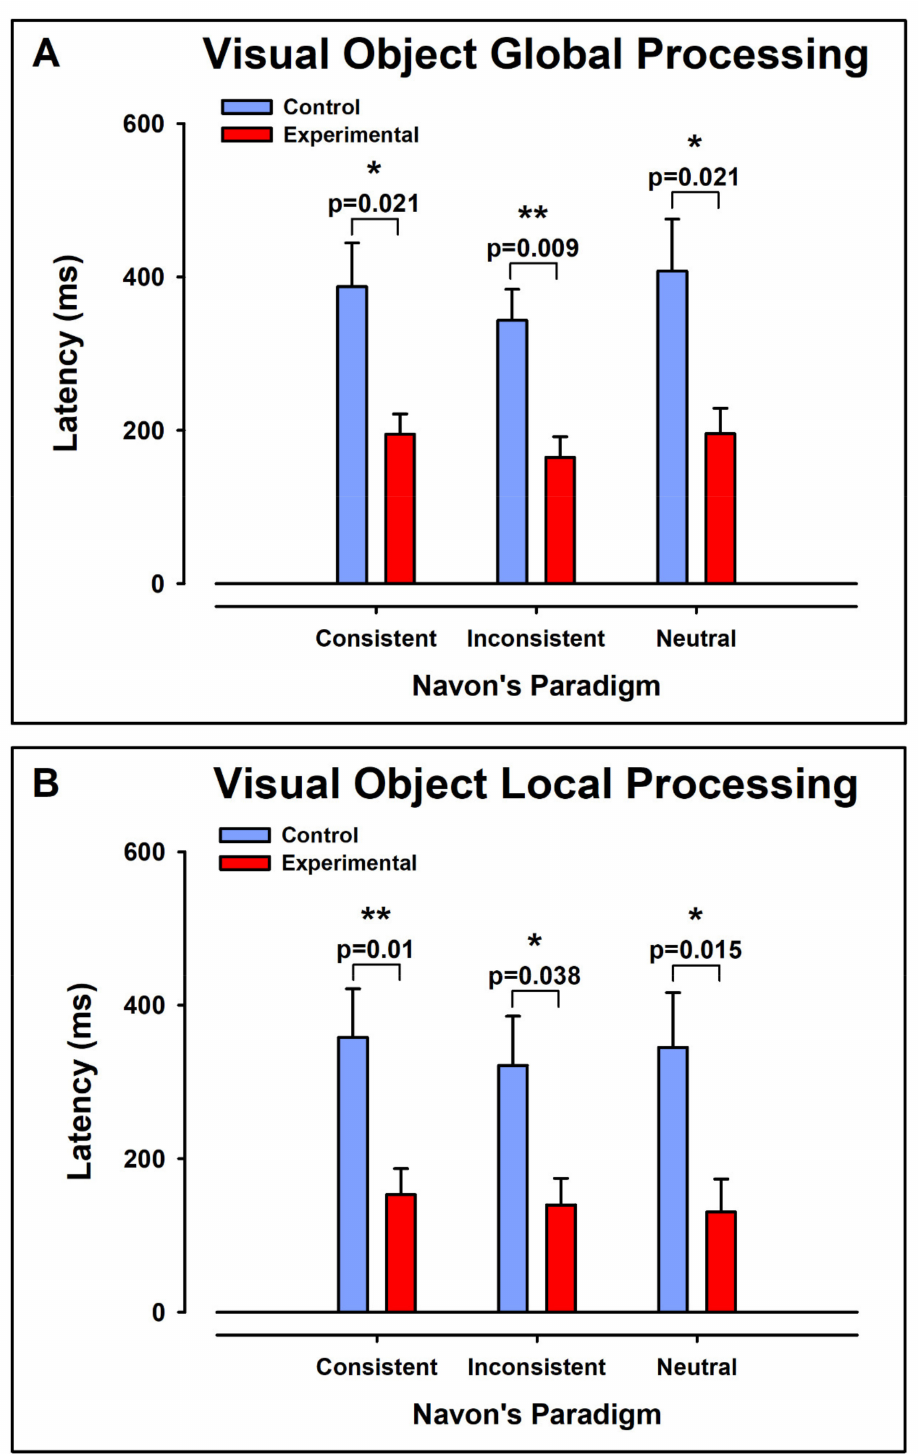
Figure 9. Comparison of the average latencies obtained from control and experimental groups. ( A ) La- tencies for Global Aspect Recognition for consistent, inconsistent, and neutral stimulus. ( B ) Latencies for Local Aspect Recognition for consistent, inconsistent, and neutral stimulus. Note that in all cases there was a significant decrease in the latencies of the experimental group. p < 0.05 is marked with * and p < 0.01 is marked with